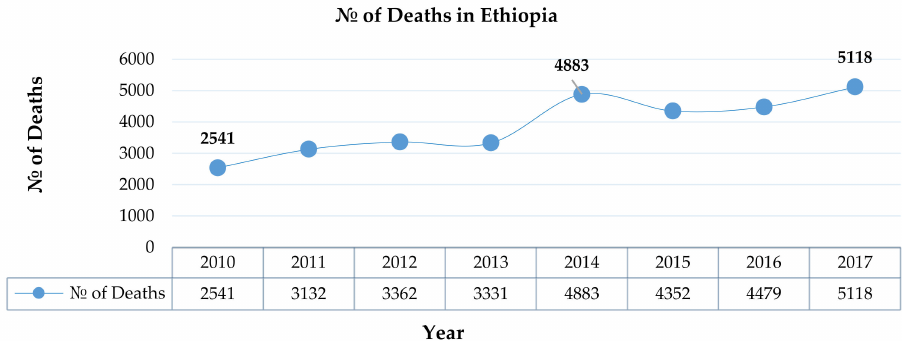
Figure 2. Number of deaths recorded in Ethiopia from 2010–2017.